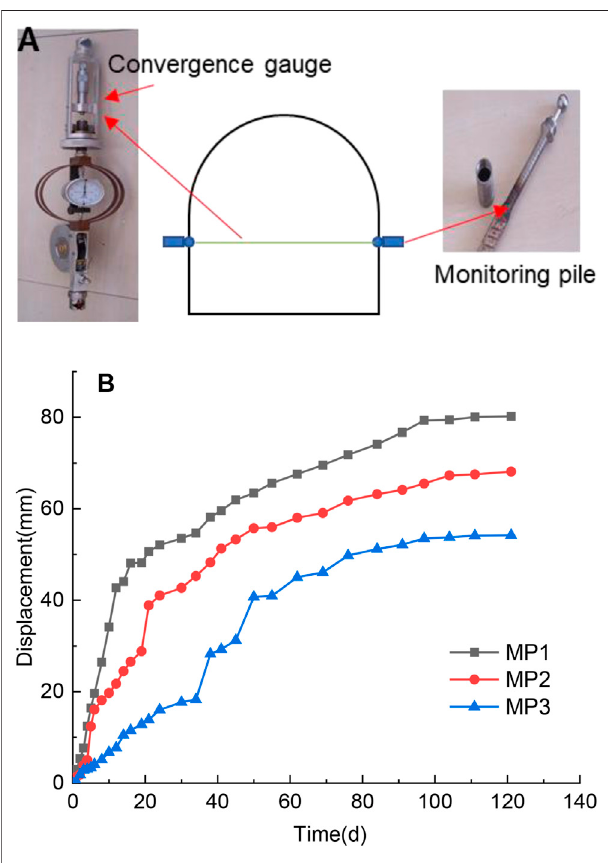
FIGURE 14 | In situ deformation monitoring. (A) Methods and facilities. (B) Relation curves between displacement and time.